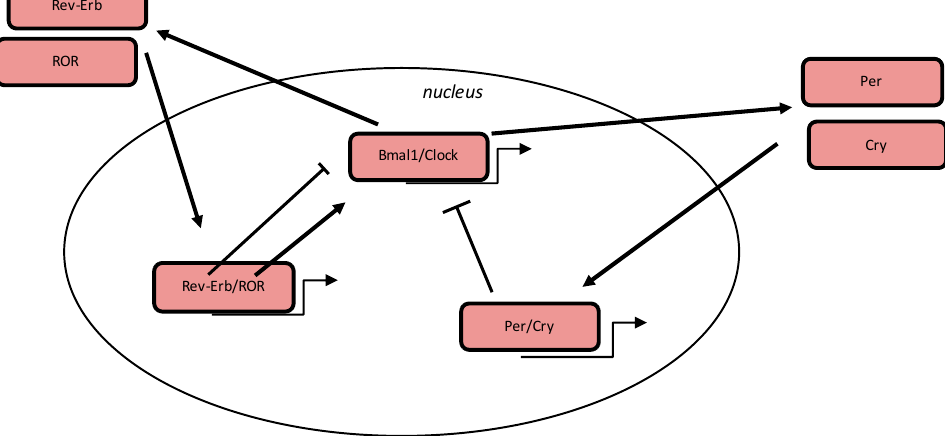
Figure 1. Circadian clock genes. The clock process is a stimulatory circle, involving the Bmal1/Clock heterodimer which activates the transcription of Period (Per) and Cryptochrome (Cry) genes, and the inhibitory feedback circle with the Per/Cry heterodimer which translocates to the nucleus and which represses the transcription of the Clock and Bmal1 genes. An additional circle implicates the retinoid-related orphan receptors (RORs) and Rev-Erb factors with a positive feedback by RORs and a negative feedback by Rev-Erb.